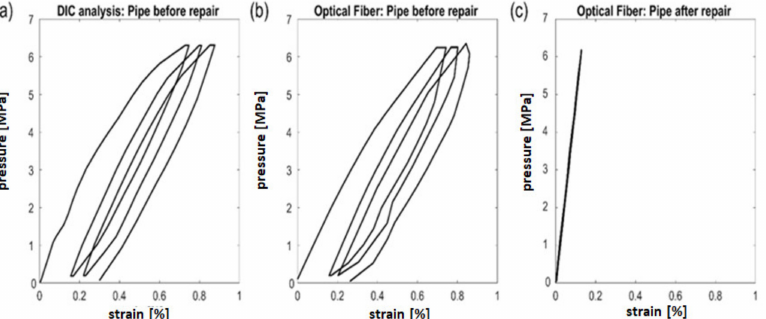
Figure 13. Circumferential strain variation along three cycles of pressurization at the most-strained points in Specimen #29 ( a ) DIC before repairing, ( b ) FBSG before repairing, ( c ) FBSG after repairing (the circumferential strain was set to zero after